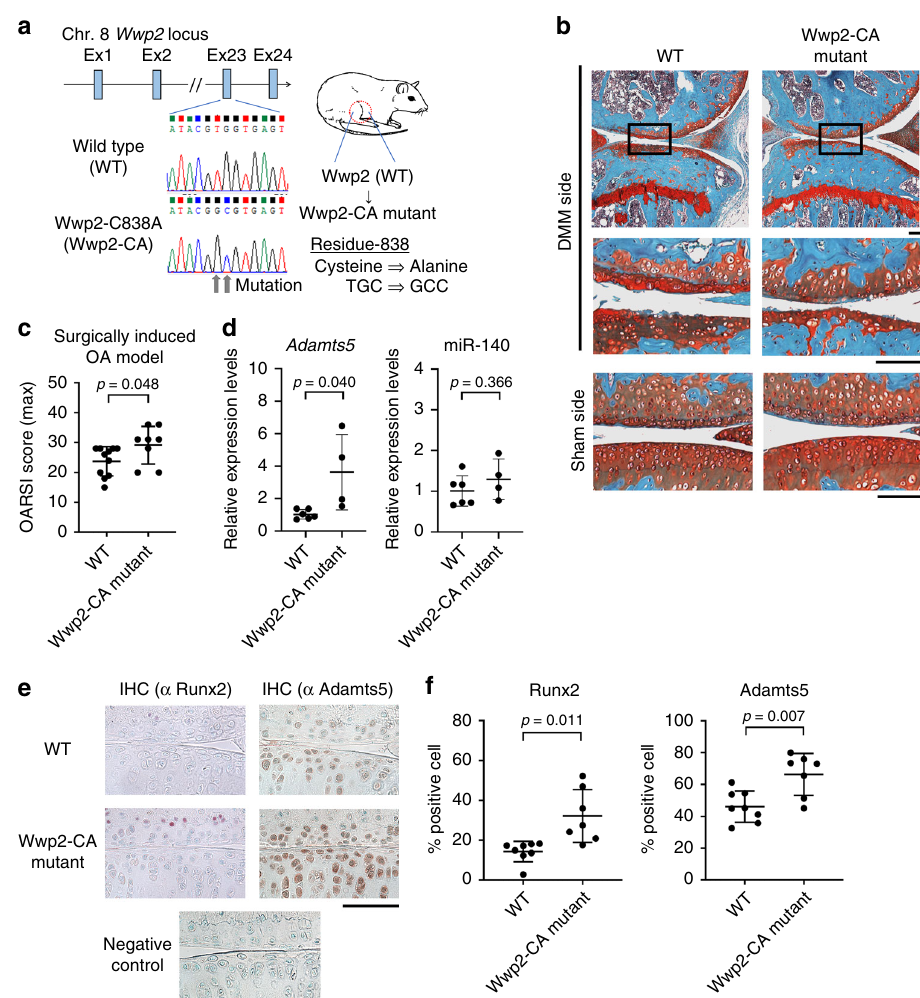
Fig. 5 Wwp2-C838A (E3 ligase inactivated) mouse promotes articular cartilage destruction. a Schema of Wwp2-CA ( Wwp2 C838A/C838A ) mutant mouse. b , c Results of surgically (DMM) induced OA murine model compared to WT and Wwp2-CA mutant mice. b Representative images of Safranin-O staining. c The maximum OARSI scores of WT and Wwp2-CA mutant mice ( n = 8-11, Student ’ s t test). d RT-qPCR for Adamts5 and miR-140 expression in mouse articular cartilage comparing wild type (WT) and Wwp2-CA mice (2-month-old). ( n = 4-6, Welch ’ s t test, normalized with Gapdh and U6snRNA, respectively). e , f IHC of Runx2 and Adamts5 for mouse articular cartilage (6-month-old). e Representative images. Negative control was stained using rabbit control IgG. f Runx2 and Adamts5 positive cell rates ( n = 7 – 8, Welch ’ s t test). Black scale bar = 1 mm. Source data are provided as a Source Data fi le. Data are presented as the mean ±